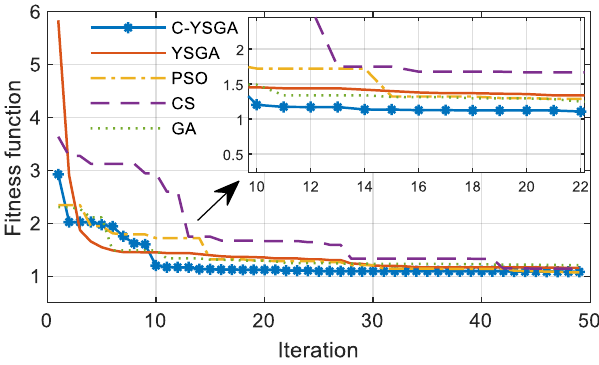
Figure 11. Convergence curves comparison for the different algorithms.